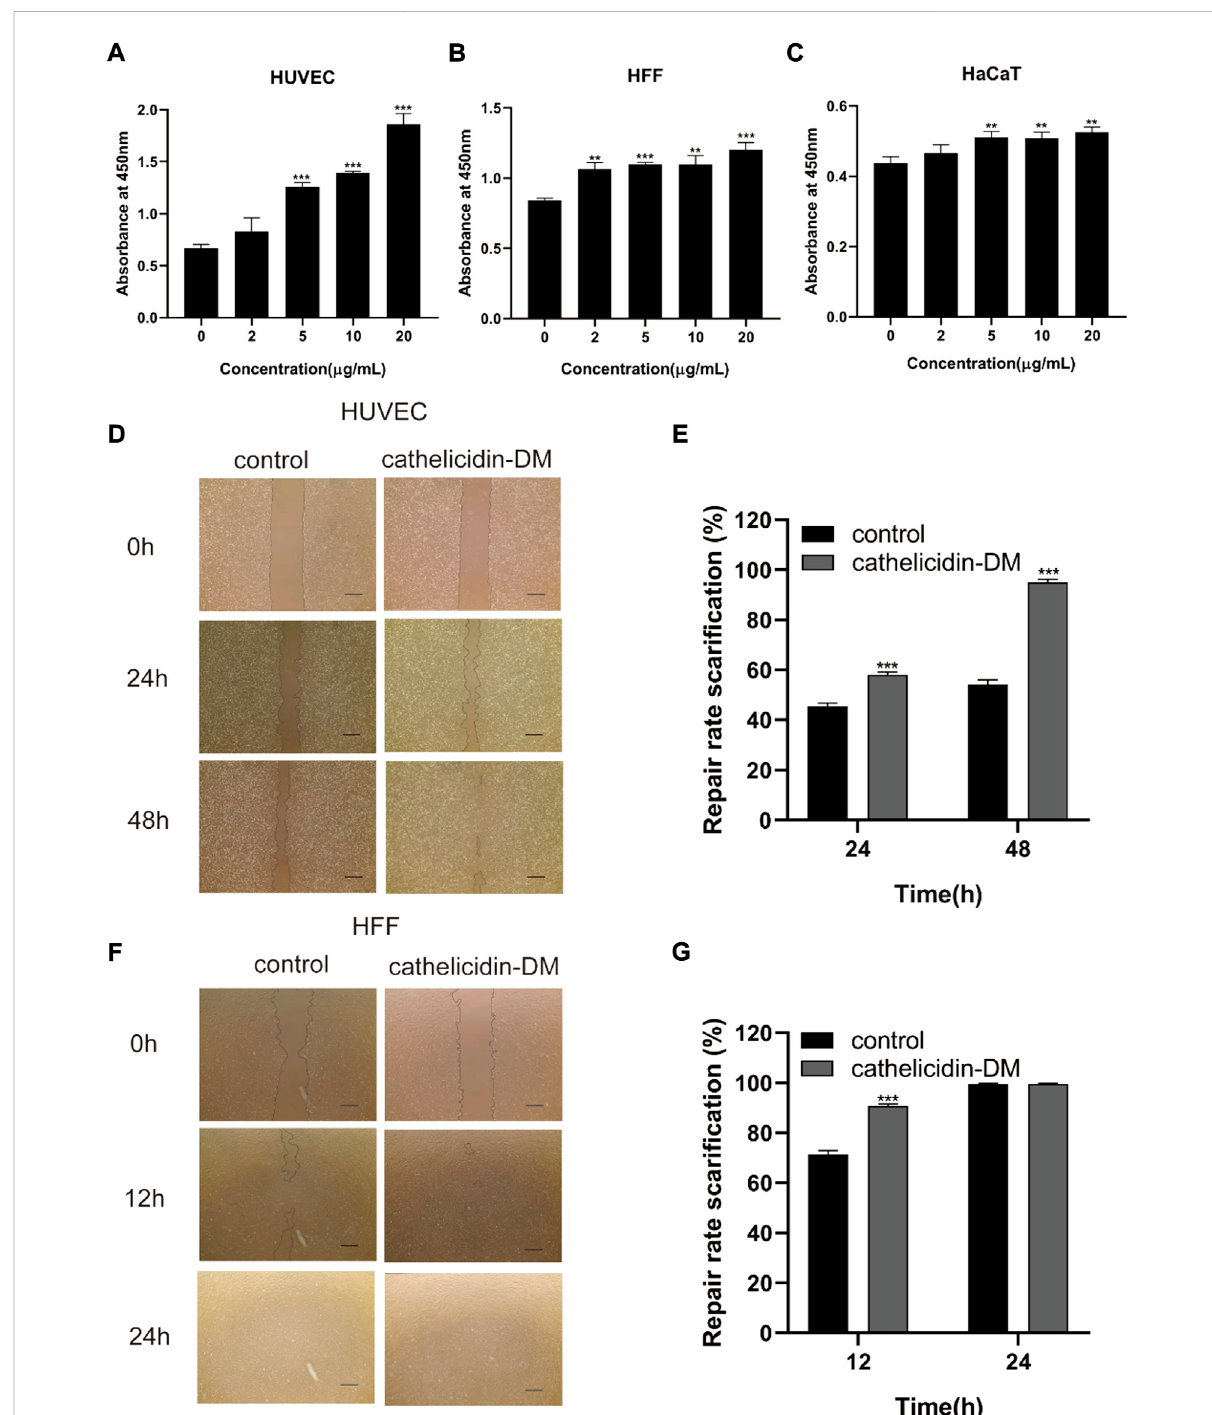
FIGURE 1 Effect of cathelicidin-DM on cell proliferation and migration. (A-C) The in fl uence of different concentrations of cathelicidin-DM on the viability of HUVEC, HFF, and HaCaT cells at 0, 2, 5, 10, and 20 μ g/ml, respectively. (D,F) Migration of HUVEC and HFF cells stimulated by 20 μ g/ml cathelicidin-DM, Scale bar represents 200 μ m. (E,G) The microscope images were quanti fi ed for analysis using ImageJ software and cell migration rateswerecalculatedintheareaofthecellscratches.Alltheexperimentswererepeated3timesandthedataareexpressedasmean±standard, * p < 0.05, ** p < 0.01, *** p <